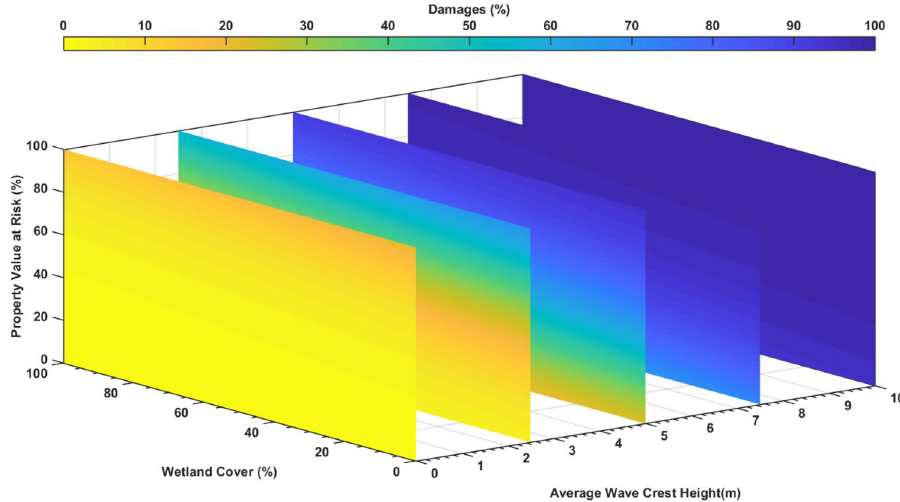
Figure 6. Zip-code structural loss regression model. A generalized regression model using a normal distribution with a logit link function. Constructed using the Structure Value at Risk, Wetland Cover, and Average Wave Crest Height as predictors to estimate structural losses in zip-codes (R 2 = 0.75, p < 0.001). Coupled with a Rapid Forecast and Mapping System 33 being developed for the region, this regression model can be used to forecast potential structural loss during an approaching hurricane. It can also be used to predict the potential loss in any hypothetical hurricane, or to plan wetland restoration to reduce loss in any specific zip code. The figure is produced using MATLAB R2020 (https ://www.mathw orks.com/).